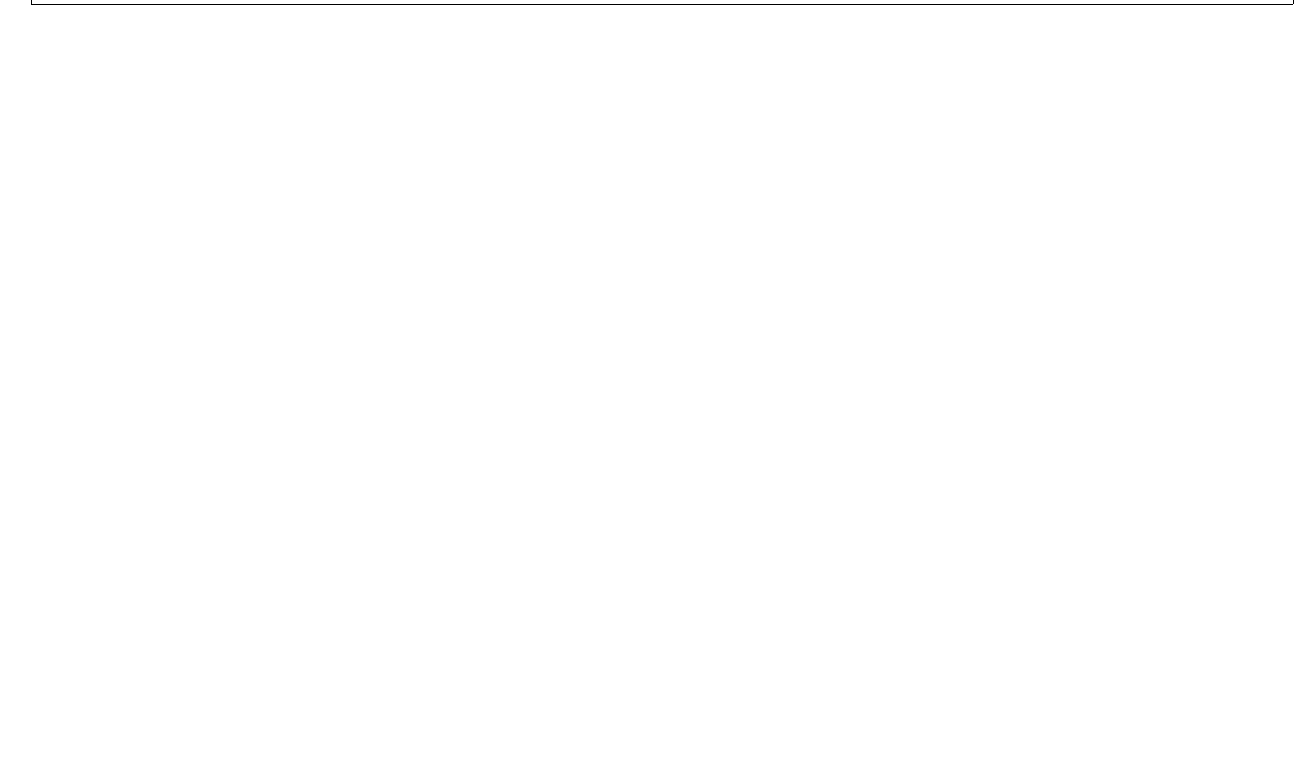
C ∗ 04:01:01-like allele, resulting in a three amino acid insertion toward the 3 (cid:3) end of the class I open reading frame. Due to the positioning of this insertion within a palindromatic sequence motif we cannot presently rule out the possibility that it is a sequencing artifact of the Roche/454 pyrosequencing